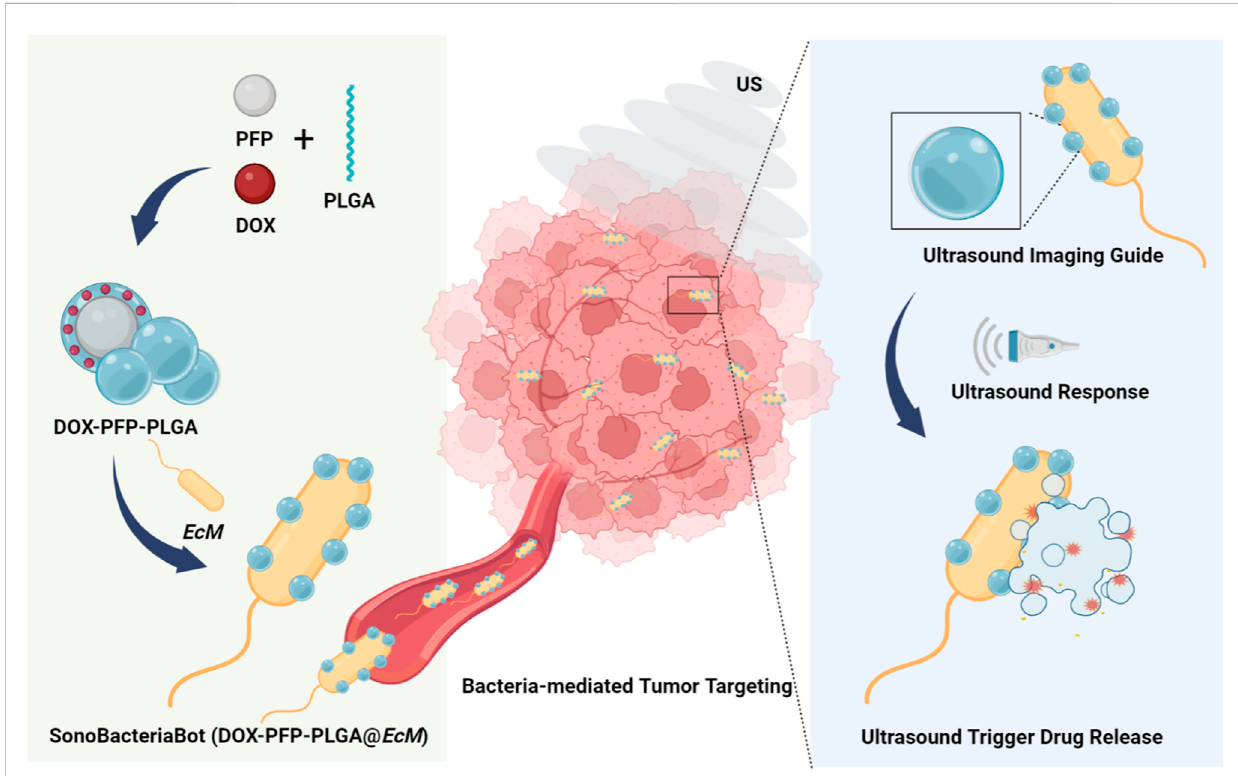
FIGURE 1 Schematic illustration of an imaging-guided US-responsive drug delivery system based on SonoBacteriaBot (DOX-PFP- PLGA@ EcM ) (Created with Biorender.com).